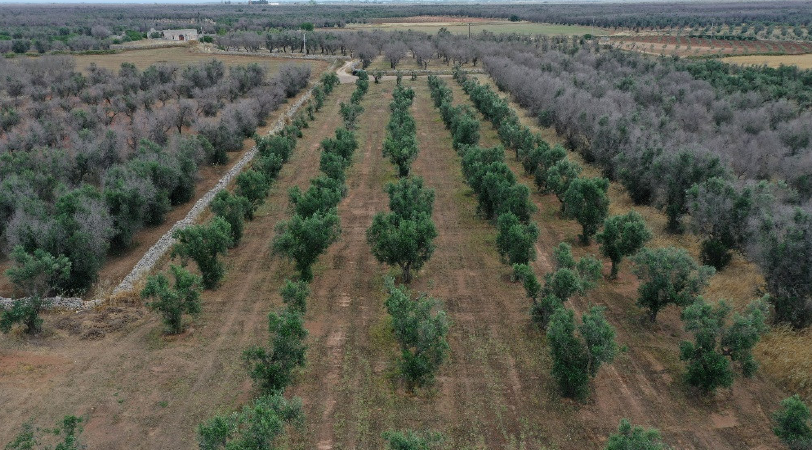
Figure 14. Olive grove trained with the local cultivars Ogliarola salentina and Cellina di Nardò at Cannole (Lecce province) (in the middle) that applies the control strategy toward Xylella fastidiosa subsp. pauca . Note the “drift effect” of the treatments on the bordering withered trees.